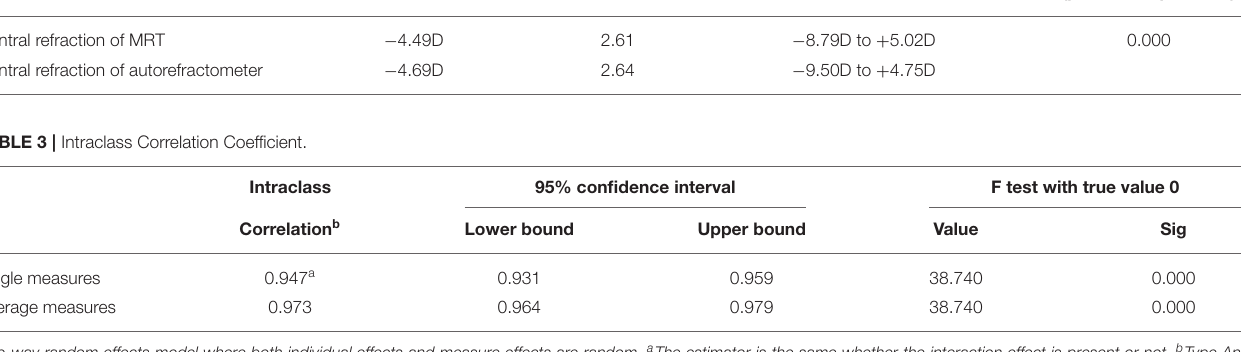
Mean Standard Range p -value(2-tailed) deviation (paired samples test)